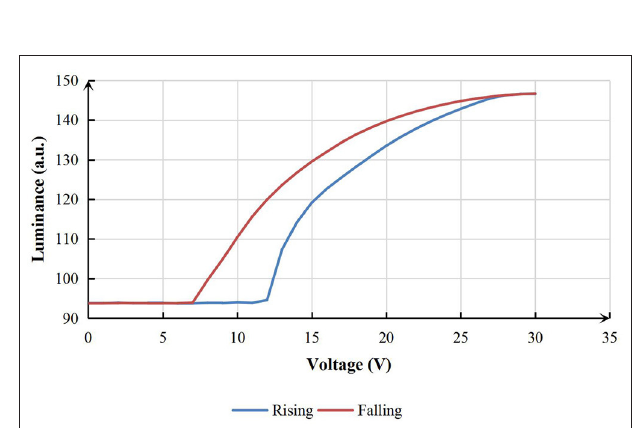
FIGURE 5 | The driving waveform used to measure the hysteresis curve of an EWD. When a stepwise changing voltage was applied to an EWD, the brightness value of the EWD was measured by a reflection colorimeter in real-time.